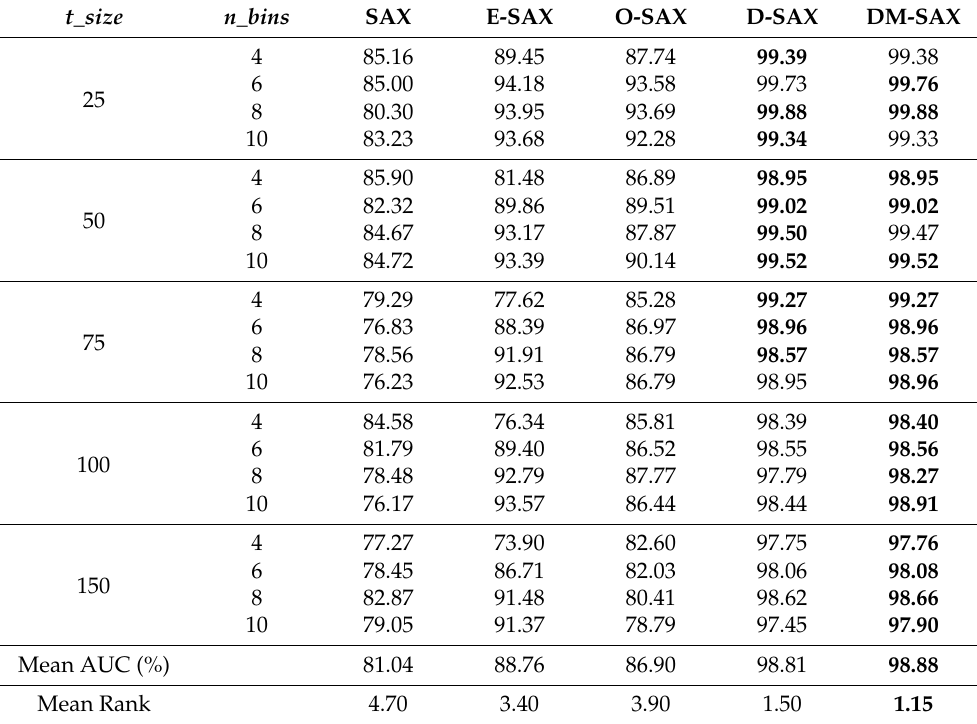
Table 8. Performance benchmarks (real-world